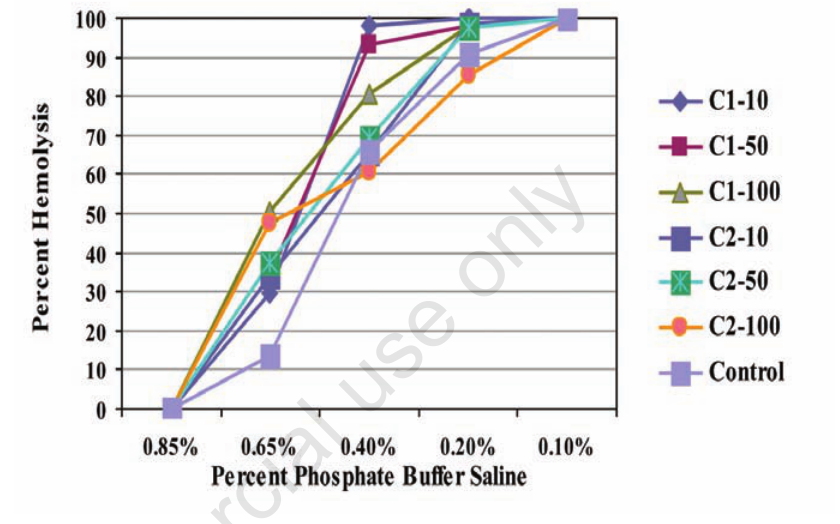
Figure 1. Osmotic fragility curve of erythrocyte treated with compounds 1 and 2. Table 1. Spectral data of Tenuazonic acid